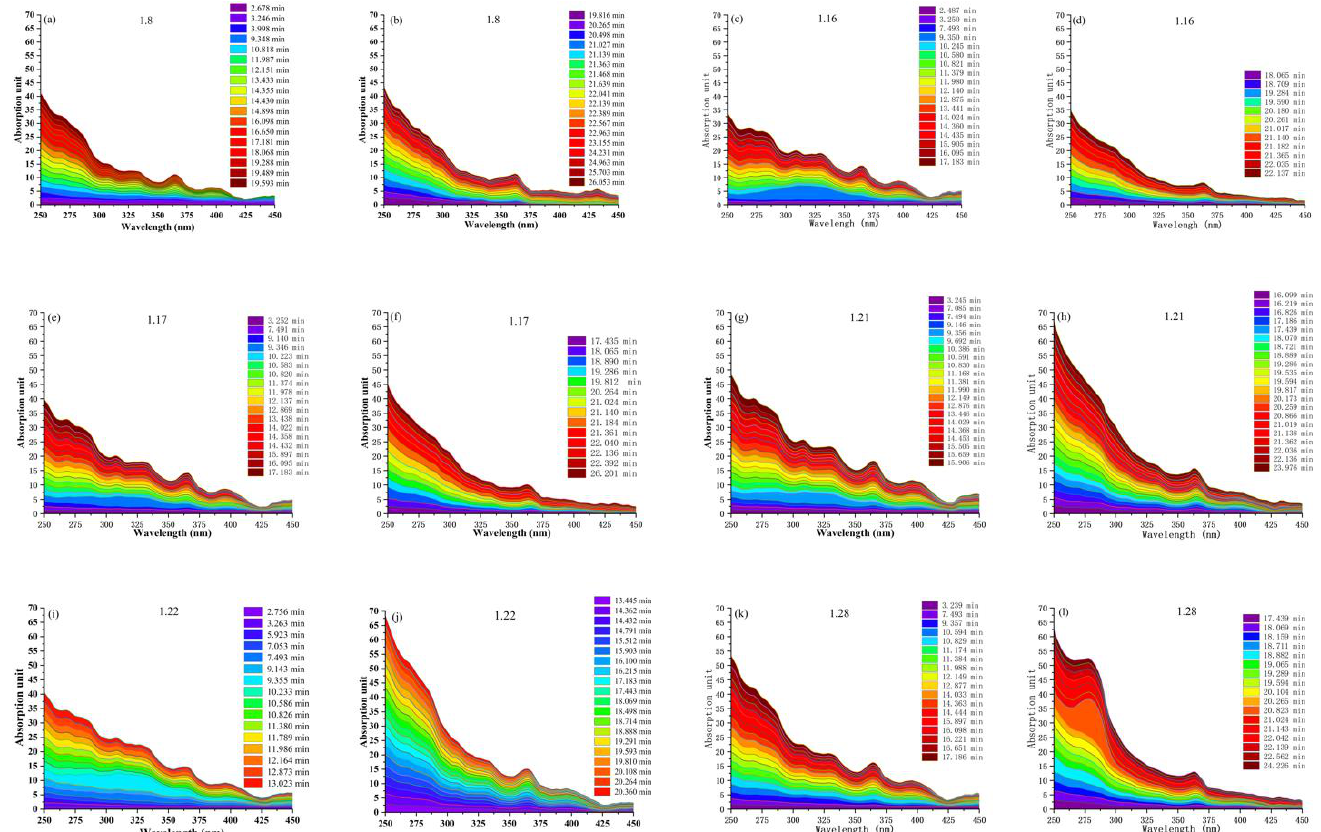
Figure 6. Relative absorption contribution of diode array detector (DAD) peaks to the total light absorption in the DAD measurement. ( a,b ) are data for January 8th, ( c,d ) are data for January 16th, ( e,f ) are data for January 17th, ( g,h ) are data for January 21th, ( i,j ) are data for January 22th, ( k,l ) are data for January 28th.